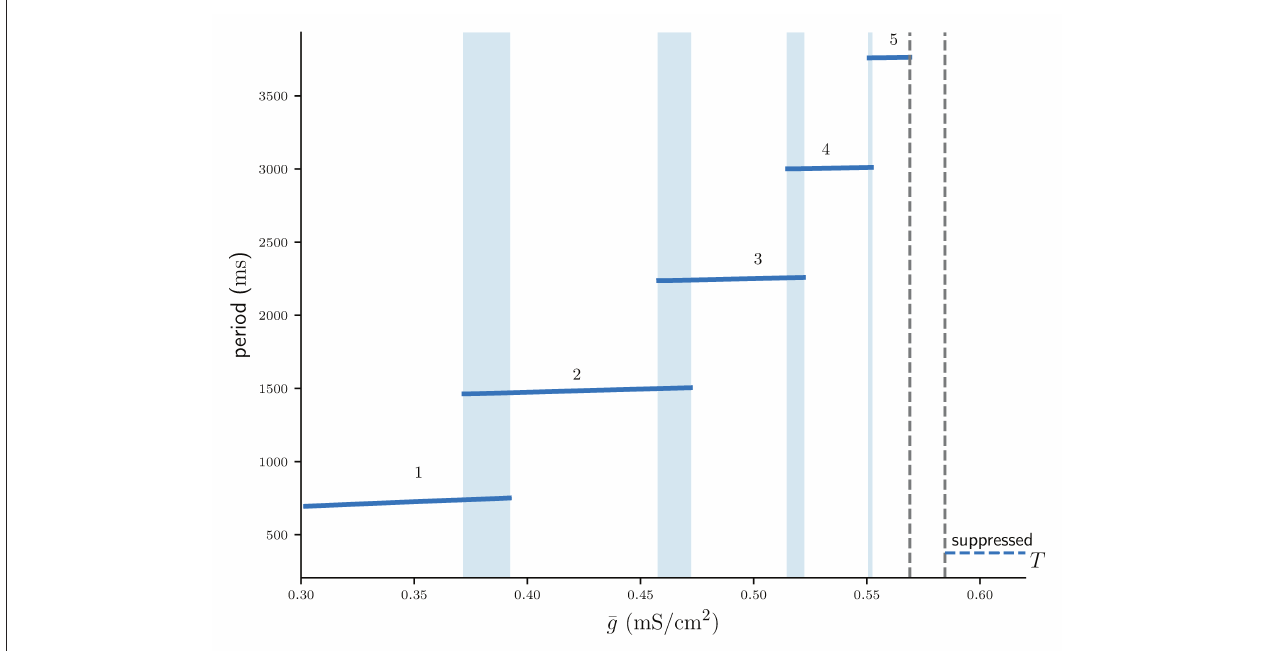
FIGURE 3 | Numerically computed bifurcation diagram of the cycle period of stable n : n solutions for increasing coupling strength ¯ g . Regions of bistability are indicated by light blue vertical stripes. Dashed lines show the interval between the 5 : 5 and the suppressed solution, where higher period n : n solutions occur on increasingly smaller intervals of ¯ g